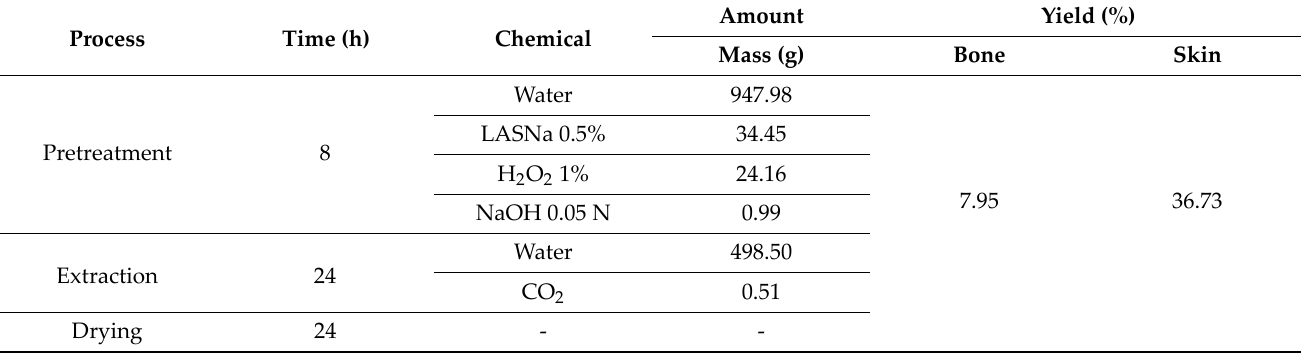
Table 4. Process efficiency of the proposed method based on 20 g of raw